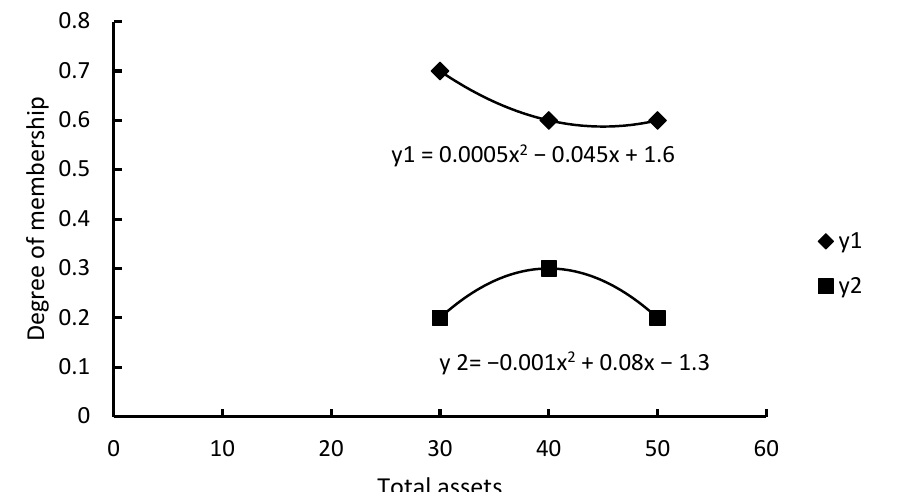
Figure A5. Single factor evaluation for the index of total assets (30–50 (inclusive) ten thousand yuan).